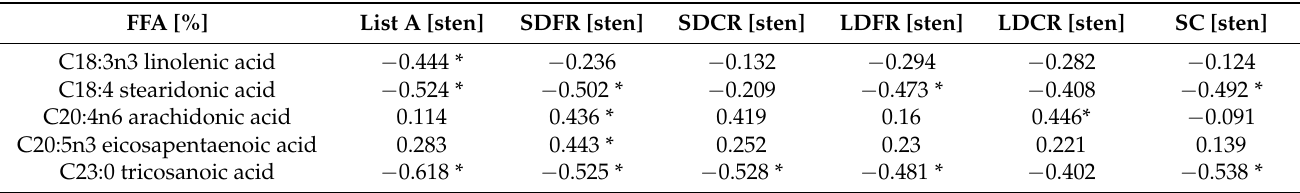
Table 2. The correlations between free fatty acids (FFAs) and Cognitive Verbal Learning Test (CVLT) score obtained on 7th day after stroke (CVLT 1).